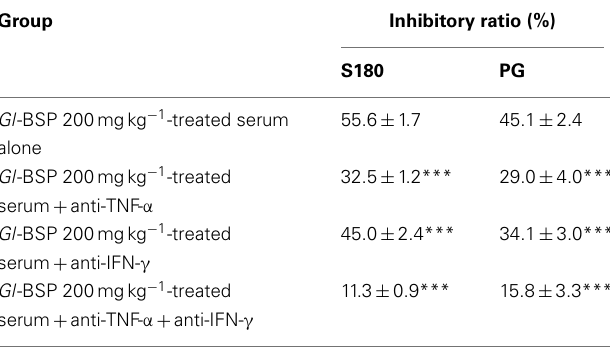
Table 8 | Effect of Gl -BSP-treated serum of S180-bearing mice preincubated with cytokine-neutralizing antibodies on the proliferation of S180 and PG cells ( n = 10, ¯ x ± s).